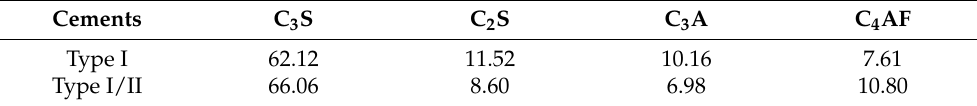
Table 2. Phase compositions of cements (% by mass)